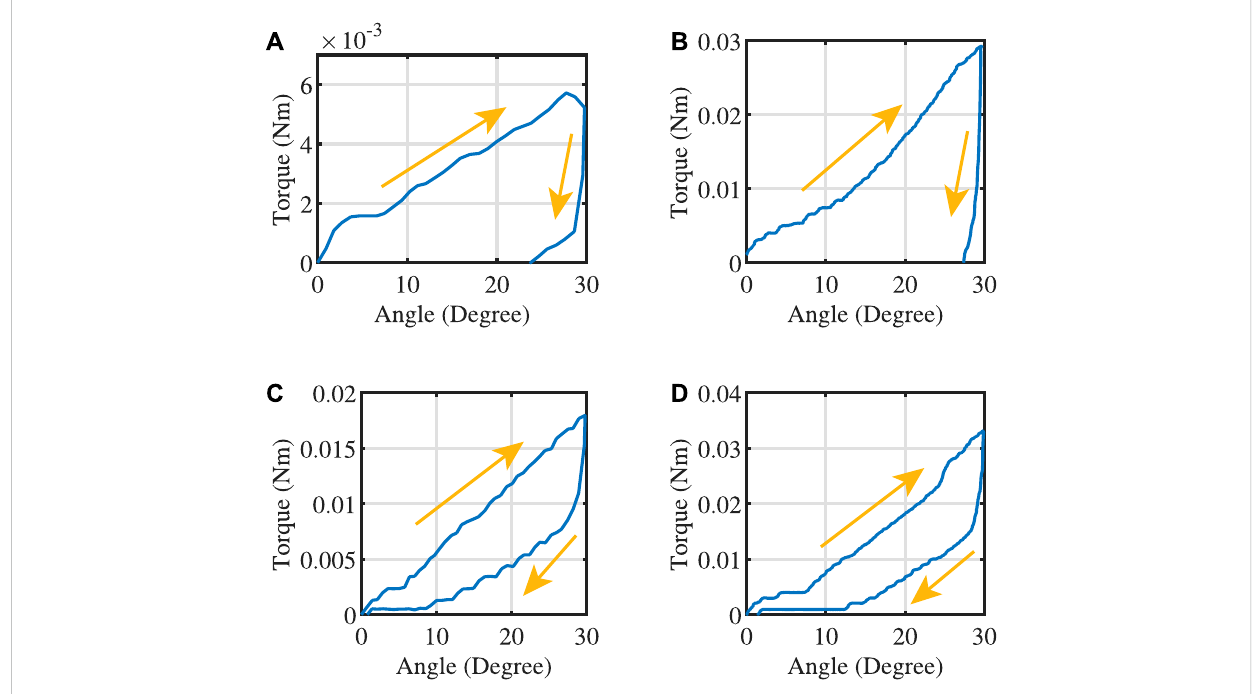
FIGURE 13 Bendingstiffnesstestresultsofkirigami-inspiredspringsprintedwithNylonmaterial. (A) Resultsofspringwith Single-Column-Flat-2mm pattern; (B) Results of spring with Single-Column-Flat-3mm pattern; (C) Results of spring with Single-Column-Flat-4mm pattern; (D) Results of spring with Double- Column-Flat-2mm pattern.